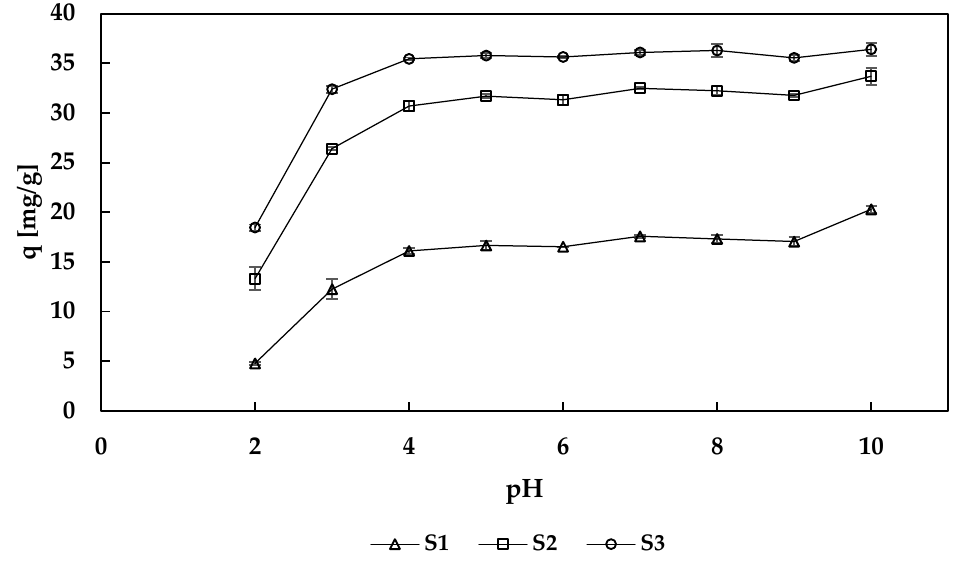
Figure 7. Effect of pH on sorption capacity (q) of sorbents (m = 30 mg, c = 115 mg/L, V = 10 mL, temp. = 22 ± 1 °C, t = 24 h).